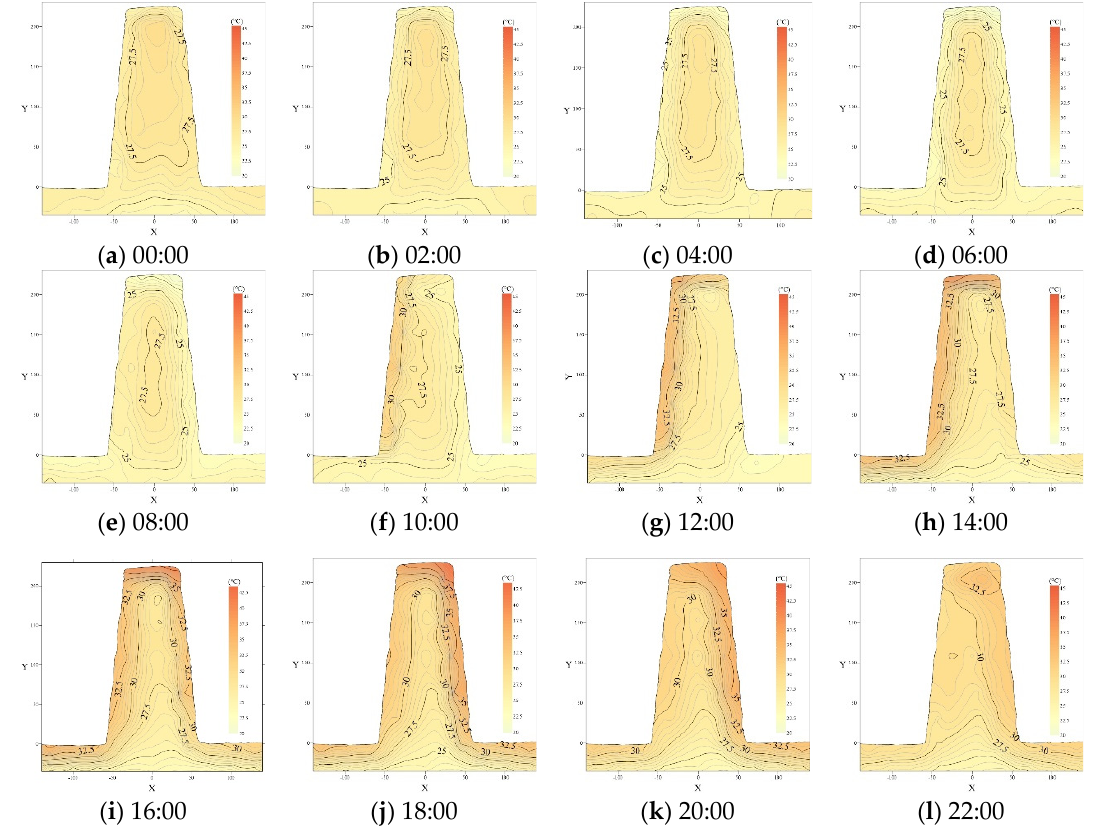
Figure 11. Temperature variation of test wall on June 16.